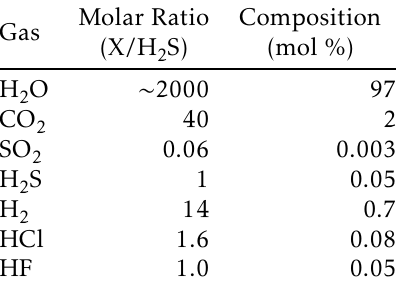
Table 1 – Gas composition from FUM01 (420 ◦ C). Molar proportions of HCl and HF determined by comparing their ratios to total S in bubblers and